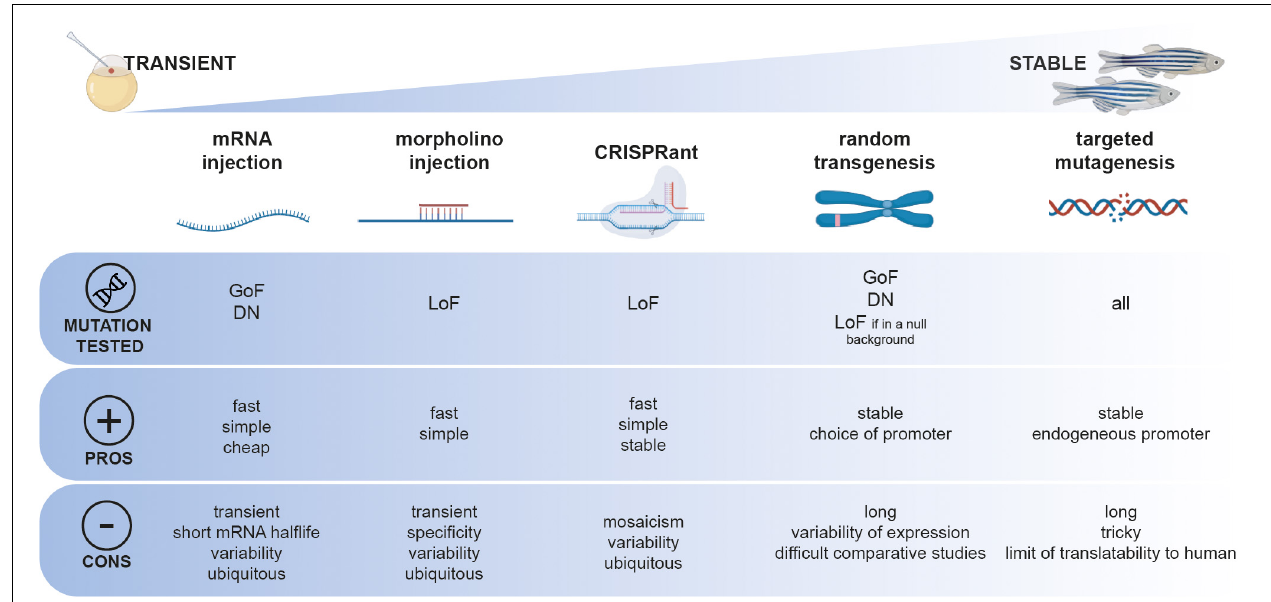
FIGURE 1 | Functional toolbox to study the function of genetic mutation in zebrafish. Different approaches, from transient to stable can be employed and can be used depending on the type of mutation to be tested (GoF, gain-of-function; DN, dominant-negative; LoF,